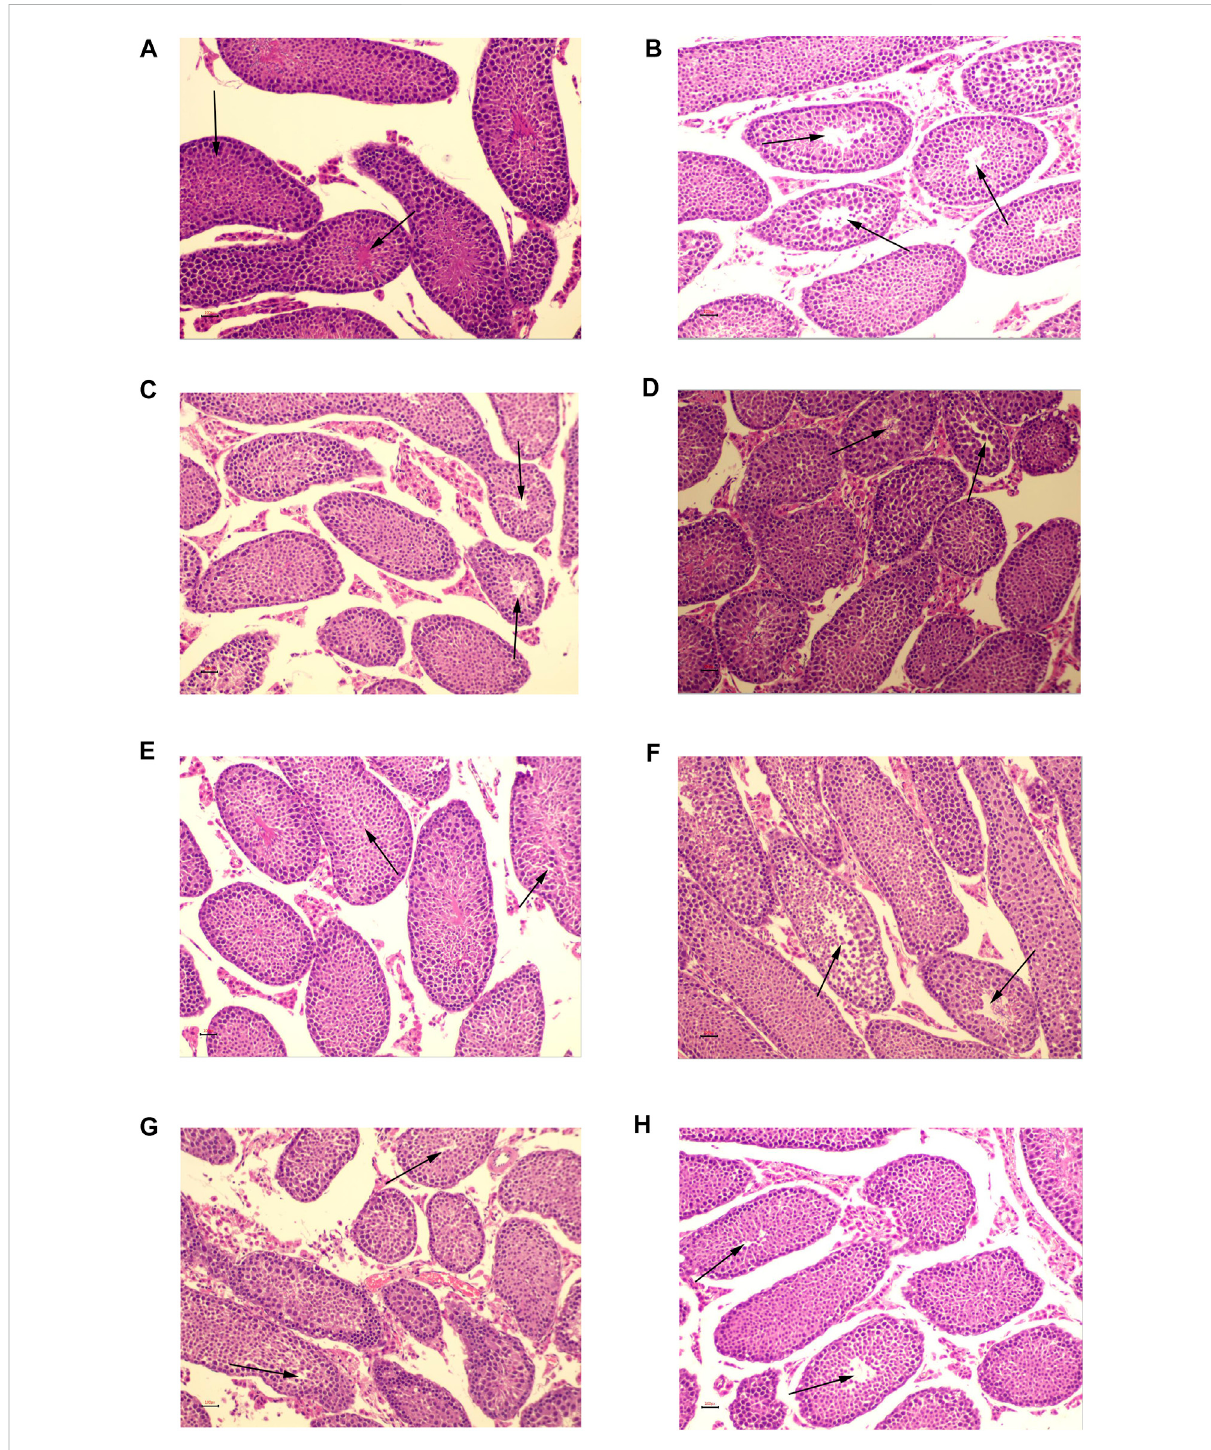
FIGURE 13 HEstainingoftesticulartissues(×200). (A) Thenormalcontrolgroup. (B) Themodelcontrolgroup. (C) Thekaempferolgroup. (D) Thequercetin group. (E) The isorhamnetin group. (F) The beta-sitosterol group. (G) The low-dose CCMM group. (H) The high-dose CCMM group. Data: n = 5, experiments performed in